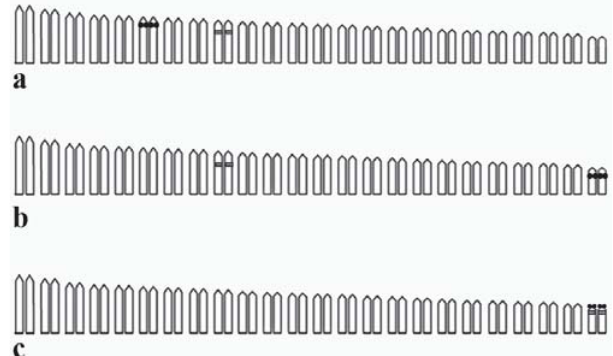
Fig. 5. Idiograms reporting the major and minor ribosomal gene locations summarizing the three main karyomorphs (a- c) identified in the species of Lutjanidae investigated so far. See text for details. Solid circles represent locations of 18S rDNA. Grey bars represent locations of 5S